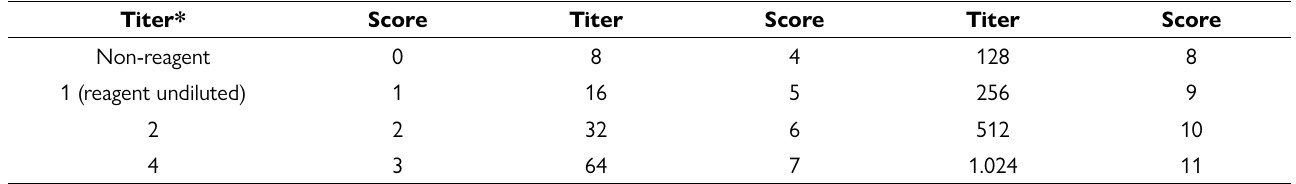
*Titer expressed as the denominator of the